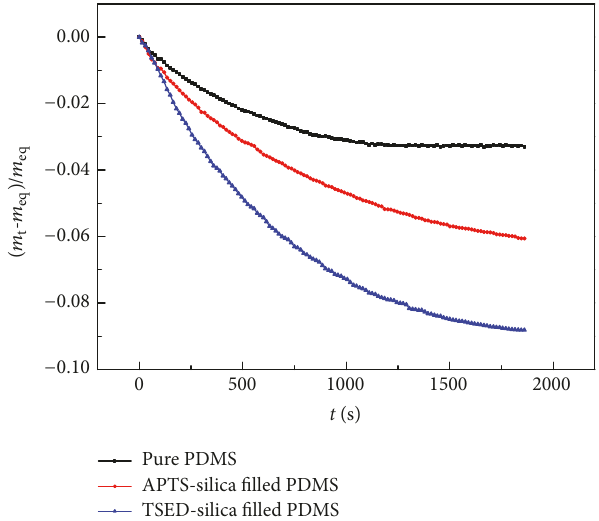
Figure 4: Mass loss as a function of t for the filled and unfilled PDMS separation